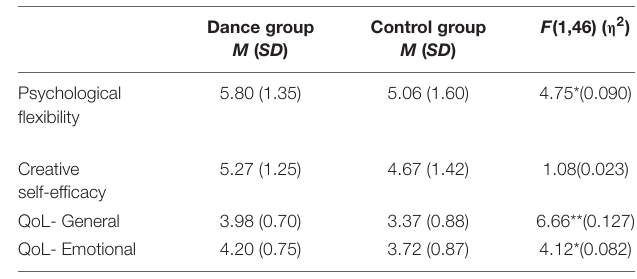
TABLE 2 | averages and standard deviations and correlations between study variables ( N = 50).